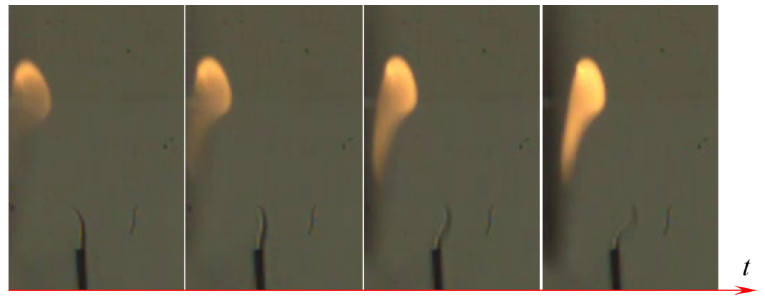
Figure 9. ( a ) Schematic diagram of fuel velocity U F ; ( b ) x ∗ flame oscillation acceleration a .